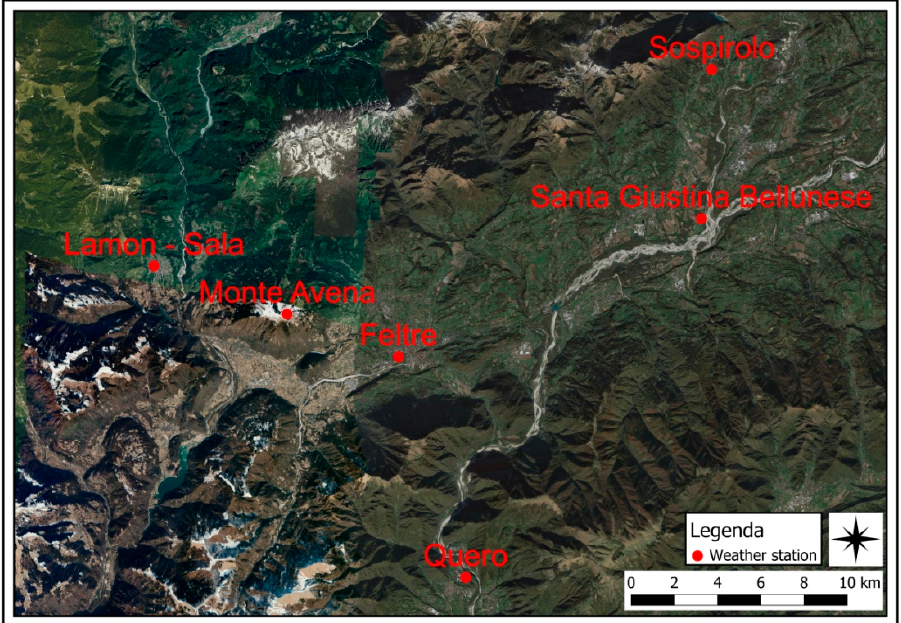
Figure 13. The 6 weather stations collected to calculate the wind gust model.